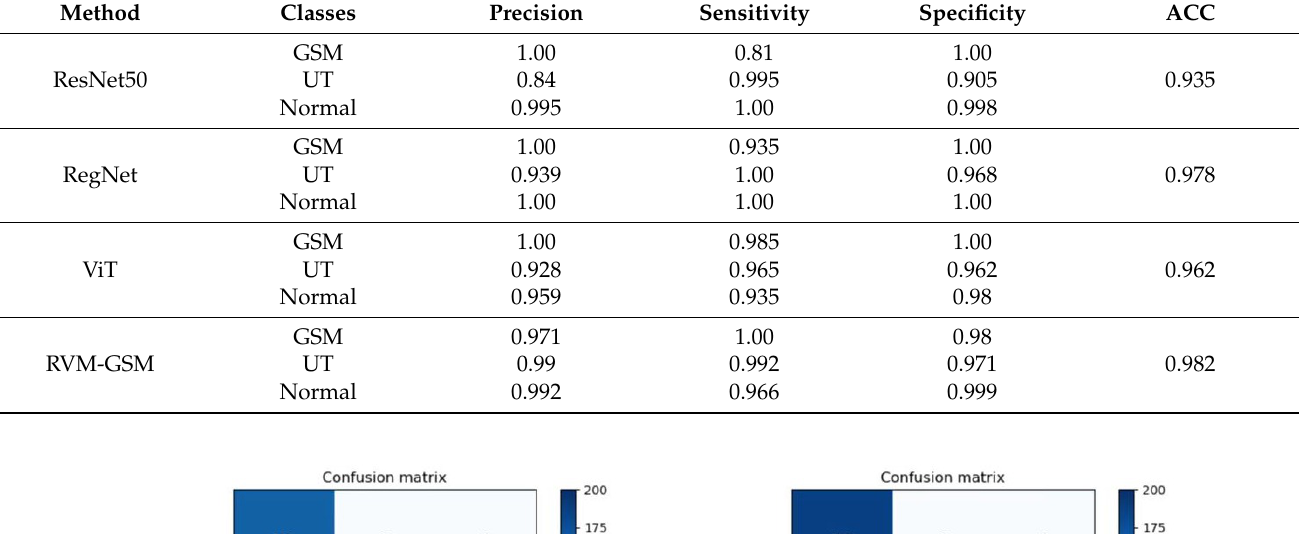
Table 1. Comparison results of models on the GSM dataset.